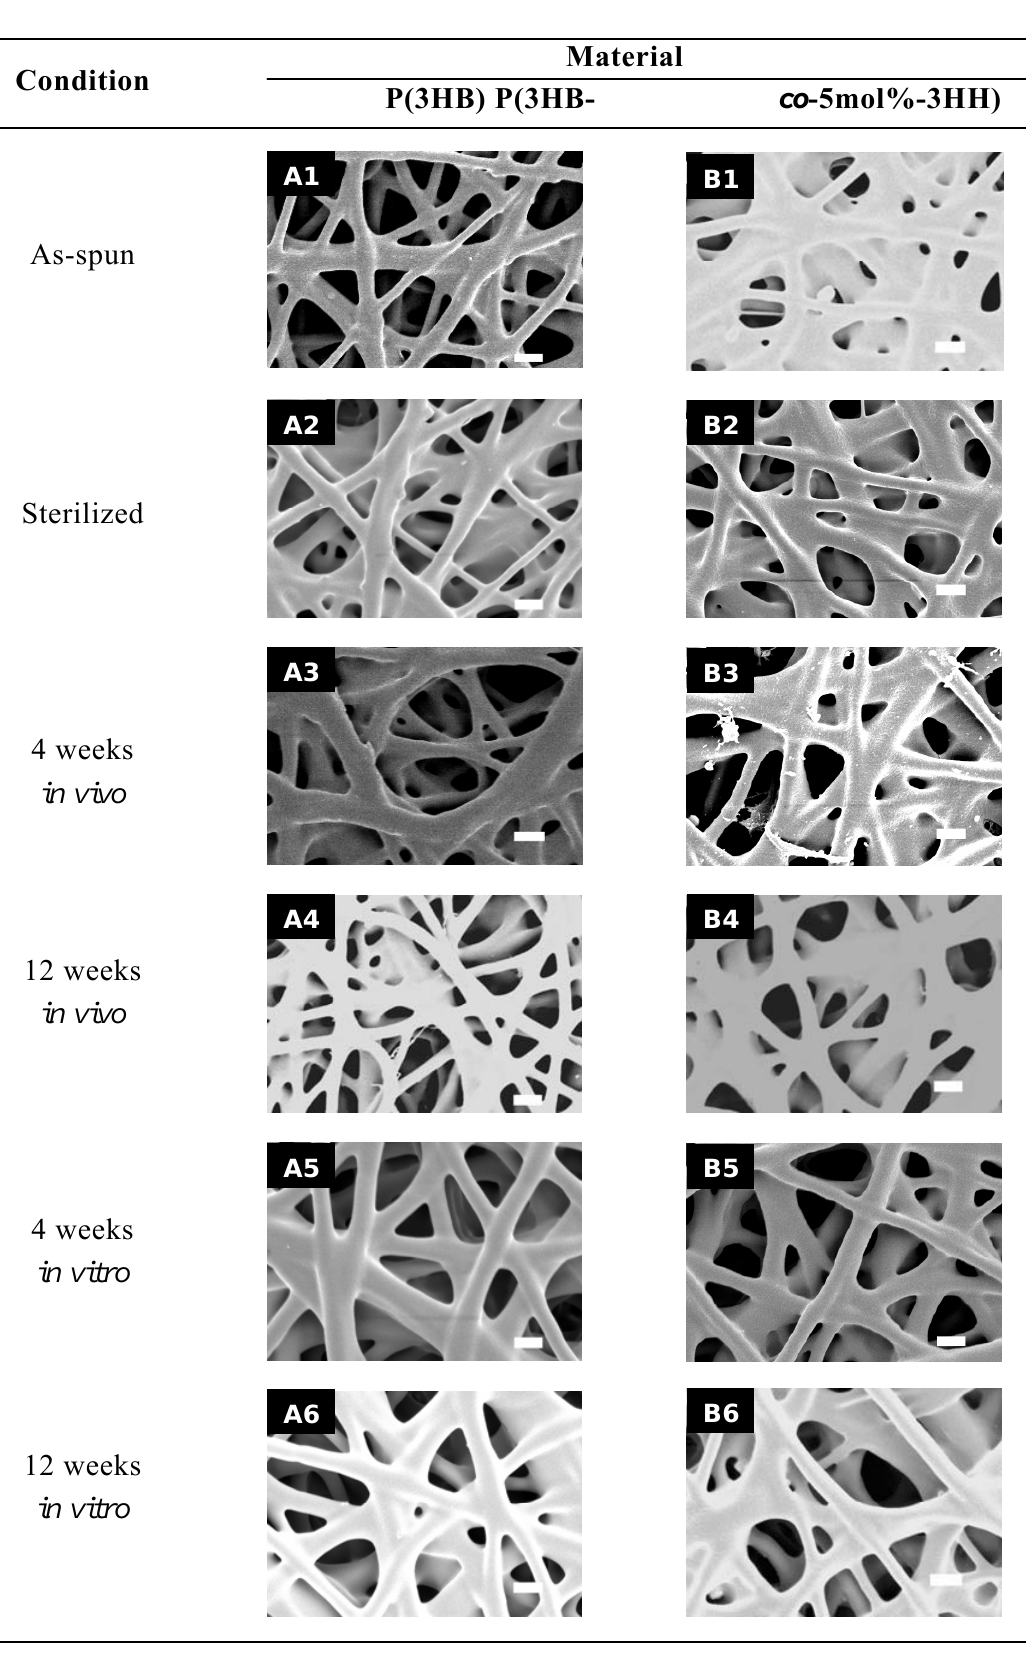
Figure 9. SEM images of PHA nanofiber scaffolds after in vivo or in vitro degradation for 4 to 12 weeks. Scale bars = 1 μ m